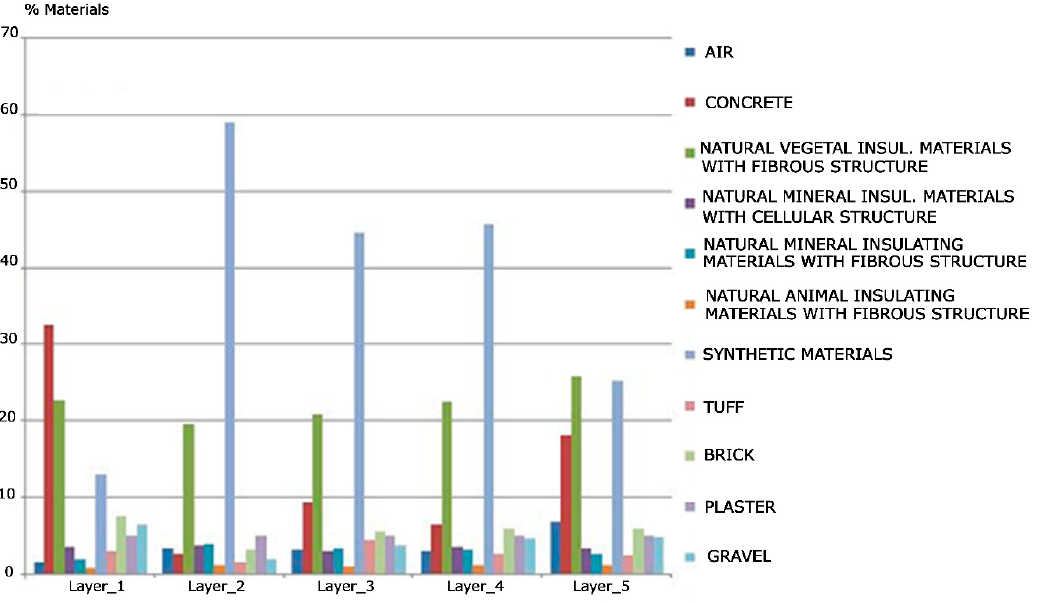
Figure 3. Histogram showing the probability of finding a particular type of insulation in the layers.